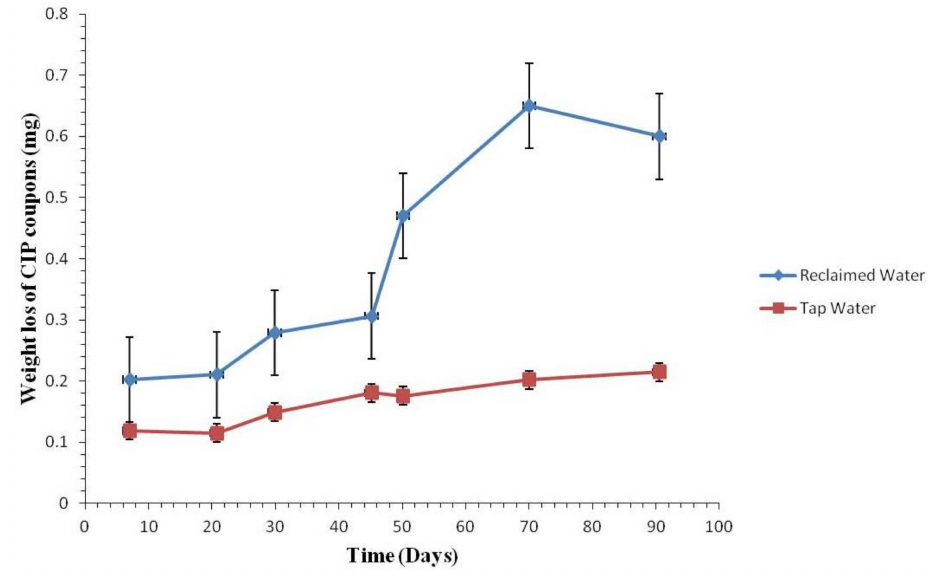
Figure 16. Weight loss of cast iron pipe coupons with RW and TW over time with standard error